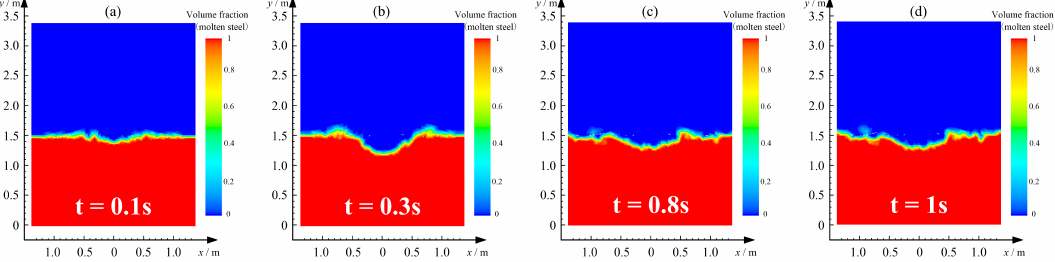
Figure 13. Spray of molten bath in the preliminary stage of top-blowing with an 8 ◦ NTA nozzle. ( a ) Flow time = 0.1 s, ( b ) flow time = 0.3 s, ( c ) flow time = 0.8 s, ( d ) flow time = 1.0